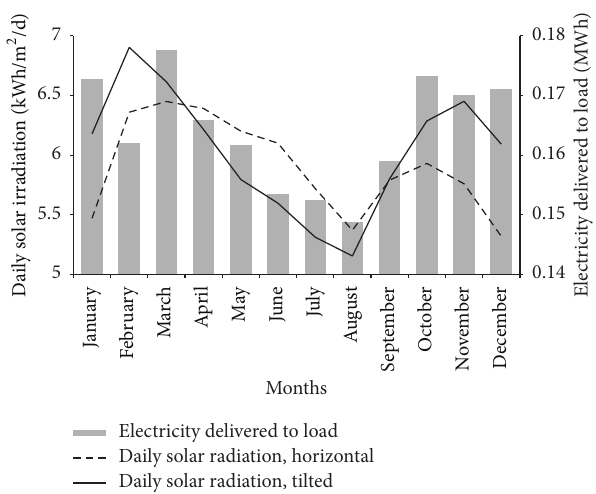
Figure2:Globalirradiationonfullsouthfixedplans(principalaxis) and energy delivered to load (secondary axis). The inclination angle is 15 ∘ . Data simulated by